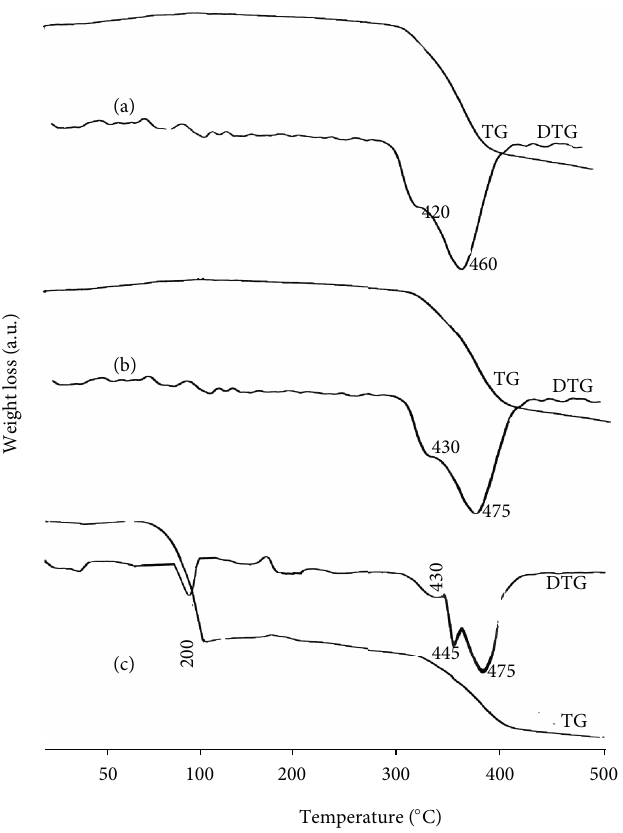
F 4: ermal analysis curves spectra of Na-ZSM-5 (a), Ni-ZSM-5 (b), and Ni-DMG/ZSM-5